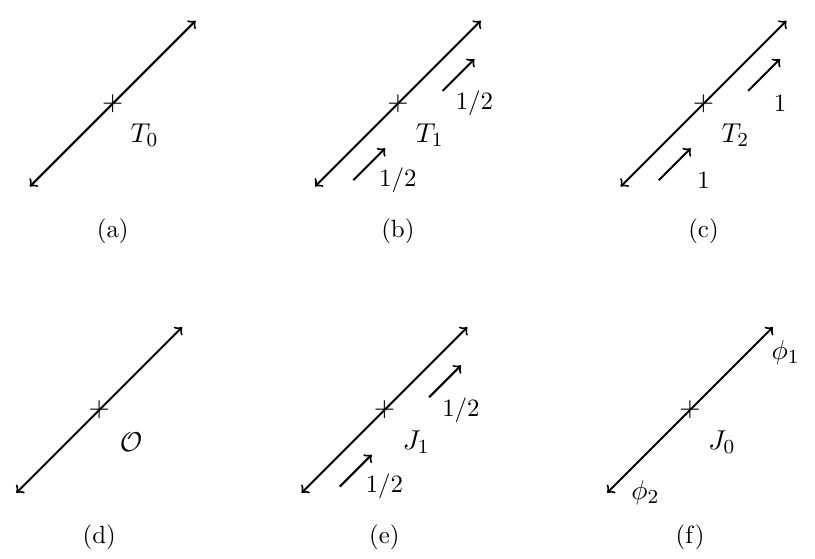
Figure 2 . We consider operators with zero spatial momentum that create a pair of free particles. In (a,b,c) we consider a stress tensor operator. We examine the wavefunction along the direction specified by the long arrow and we decompose the stress tensor according to the spin around that axis. (a) The spin zero state is obtained for scalars, spin one for fermions (b) and spin two for vectors or self-dual forms (c). (d) is the state produced by a scalar operator with can interfere with (a). (e) is produced by a current with spin one along the observation axis and can interfere with (b). Finally (f) is a current with spin zero along the observation axis in a theory of scalars. It produces two different real scalars in the back to back configuration and cannot interfere with